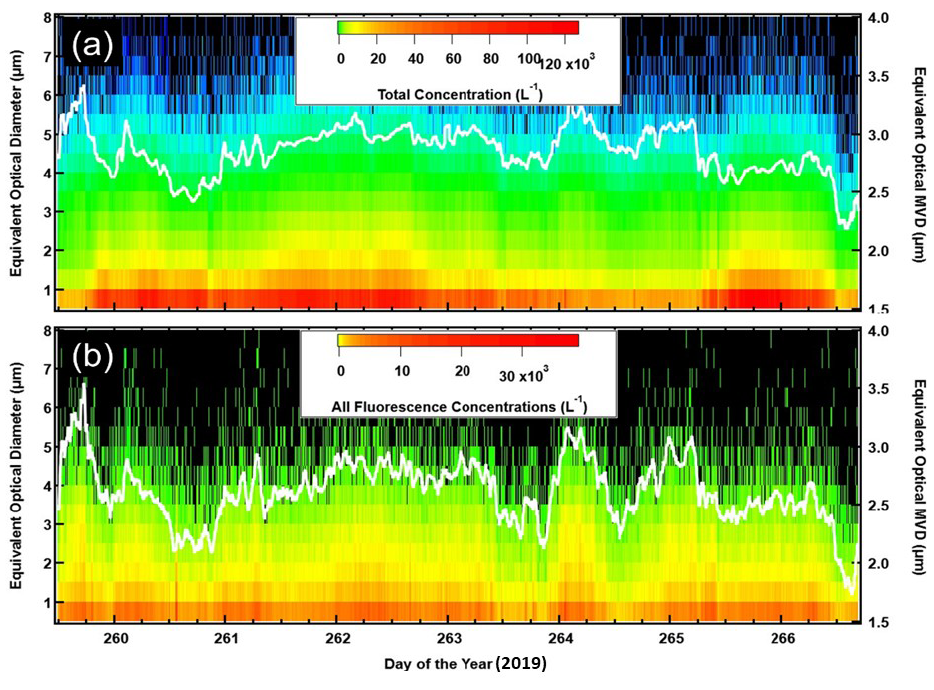
Figure 4. Time series of (a) total and (b) fluorescent particle size distributions measured by WIBS for the period from 16 to 23 September (DOY 259–266) 2019. The white curves are the average median volume diameters (MVDs).